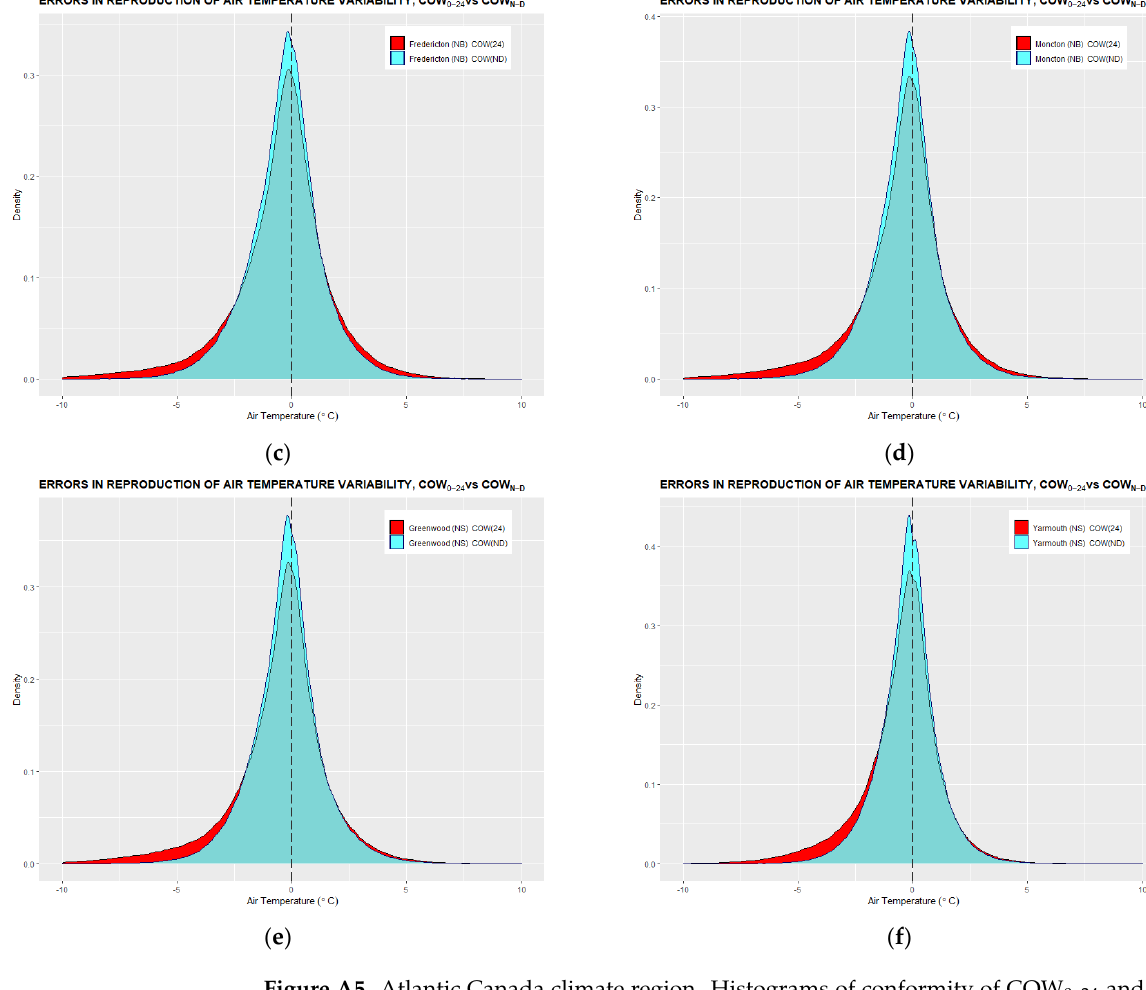
Figure A5. Atlantic Canada climate region. Histograms of conformity of COW 0–24 and COW N–D reproduced temperature with observed hourly temperature data for the 1959–2018 data period at St John’s ( a ) and 1953–2018 at Charlottetown ( b ), Fredericton ( c ), Moncton ( d ), Greenwood ( e ), and Yarmouth ( f ) stations.